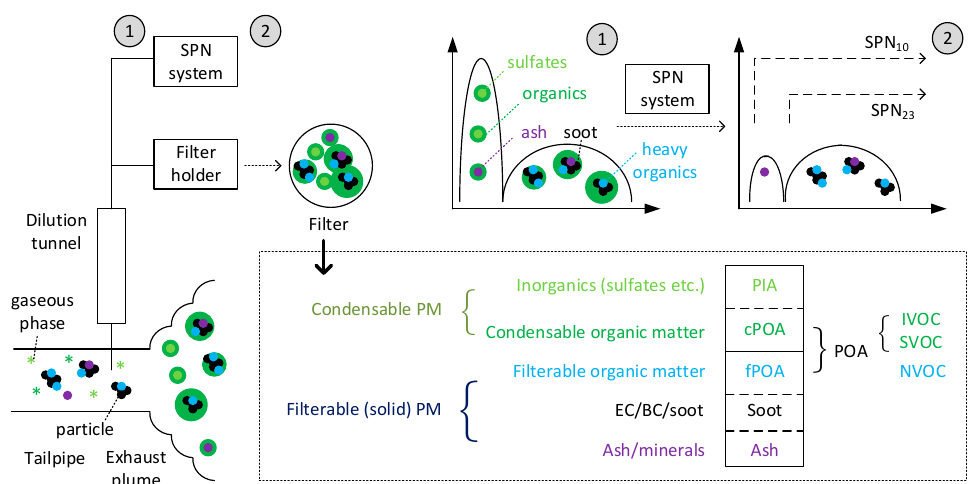
Figure 1. Tailpipe “primary” and fresh aged “delayed primary” aerosol consisting of inorganics, organics at the gaseous or particle phase, and soot and ash particles. On the right side the filter based and solid particle number (SPN) counting methods are plotted. Based on [15,16,32,146]. cPOA = condensed primary organic aerosol; IVOC = intermediate volatility organic compound; NVOC = non-volatile organic compounds; PIA = primary inorganic aerosol; POA = primary organic aerosol; PM = particulate matter; SPN = solid particle number; SVOC = semi-volatile organic compound.